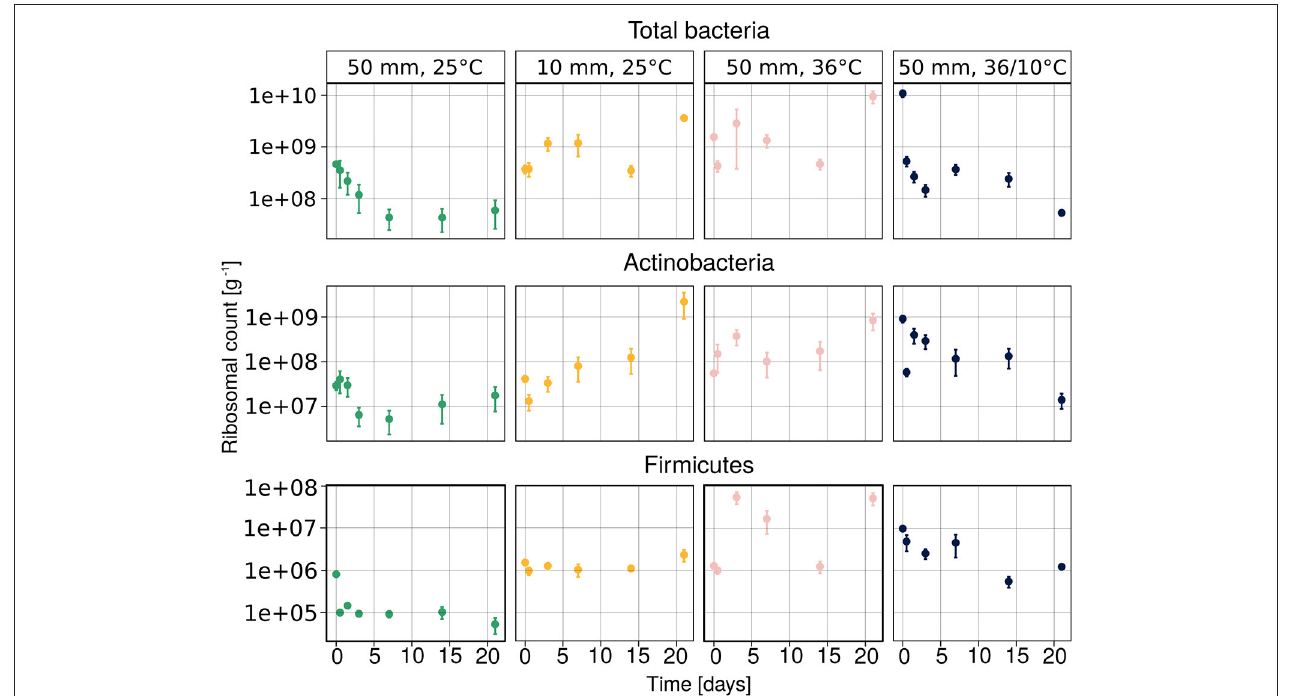
FIGURE 3 | Abundance of total bacteria, Actinobacteria and Firmicutes ribosomes, measured by the qPCR method. Average values of three samples are presented as mean ± SEM.